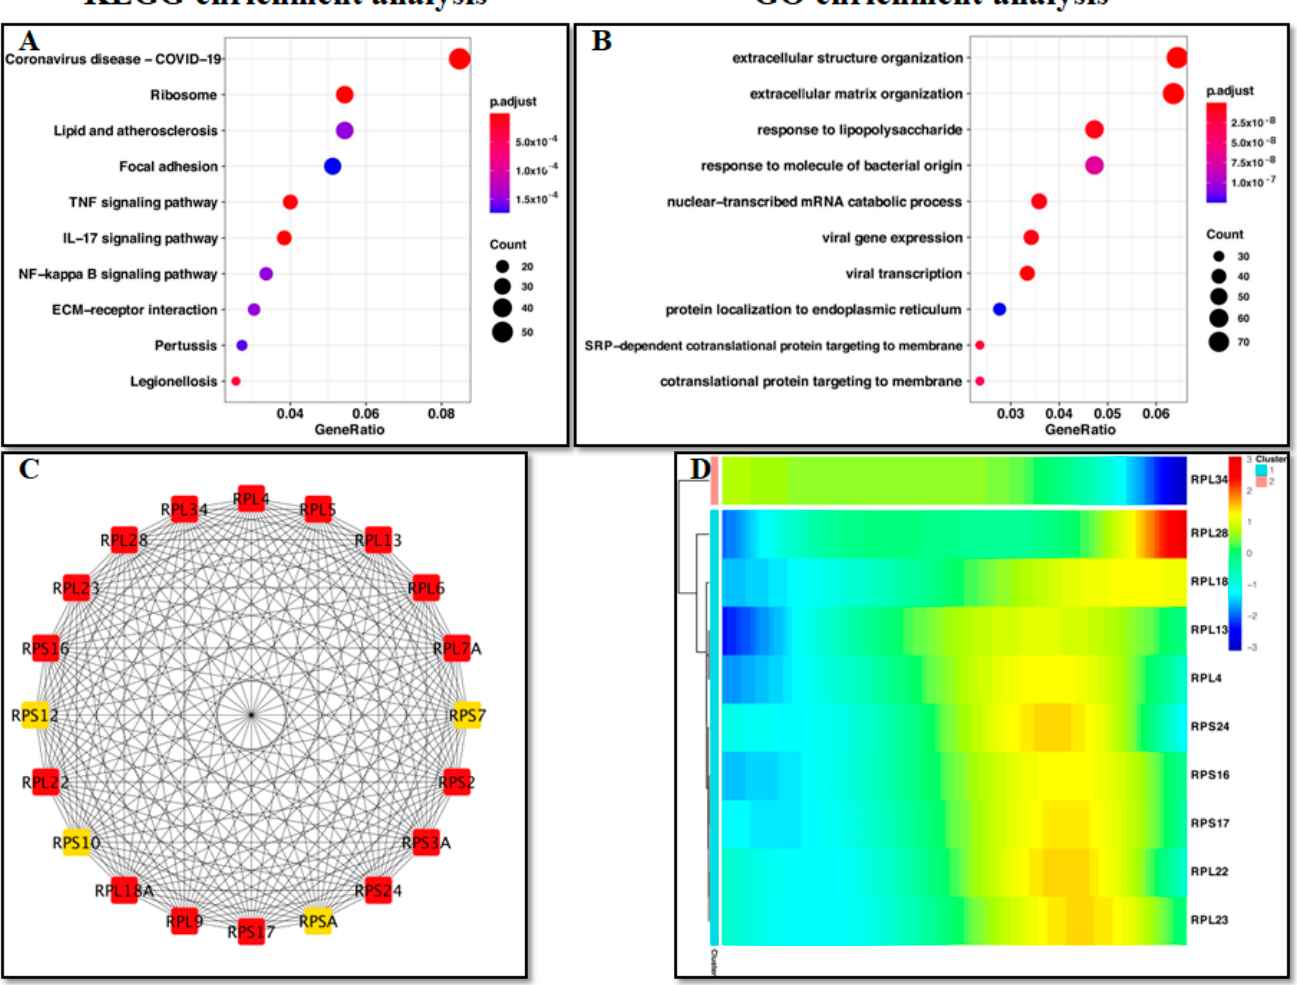
Figure 4. Exploring the functions of genes related to fibroblast differentiation. ( A ) KEGG enrichment analysis. ( B ) GO enrichment analysis. ( C ) PPI analysis of the top 20 DEGs. ( D ) Expression of the top 10 DEGs associated with fibroblastic differentiation.